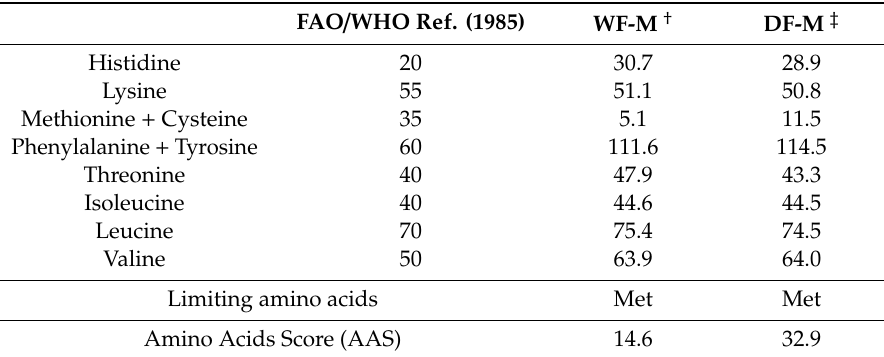
Table 2. Essential amino acid amounts and amino acid scores of mealworm powders.